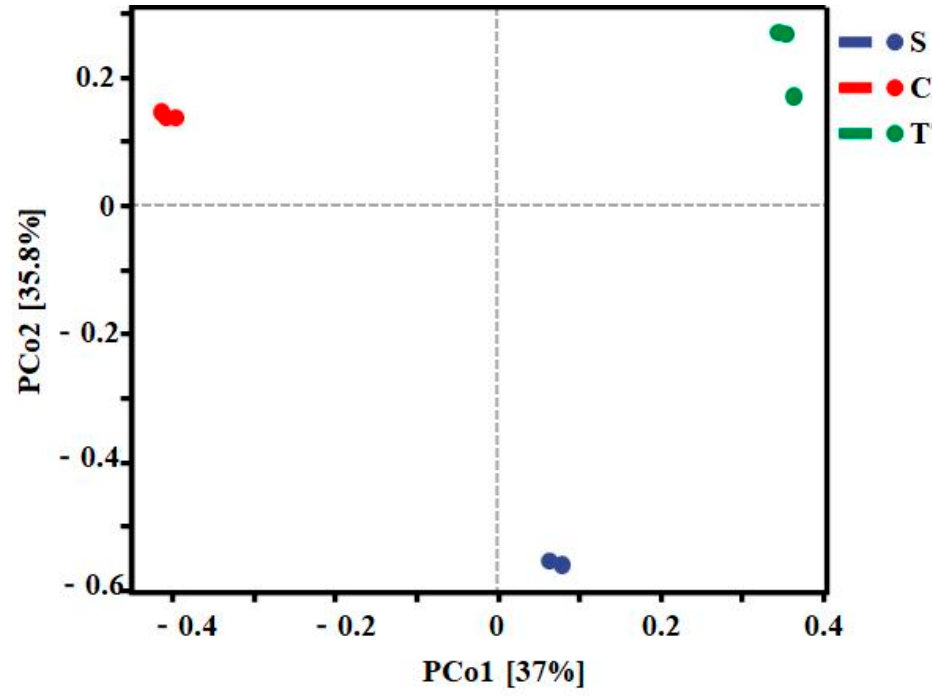
Figure 5. PCoA plots of bacterial communities in soil samples with different treatments. (Unactivated original contaminated soil (S), soil without any additive (CK), BC-nZVI, 10 g/kg (T7)).